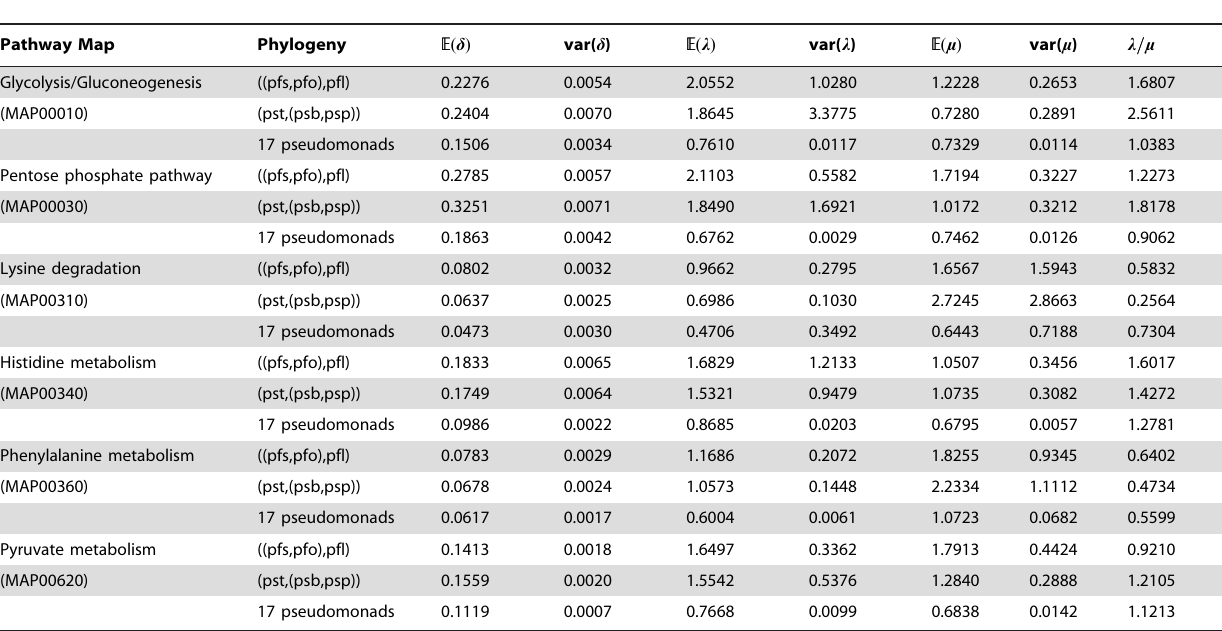
Table 2. Posterior expectation and variance of evolution parameters estimated using the Gibbs sampler under the hybrid model.